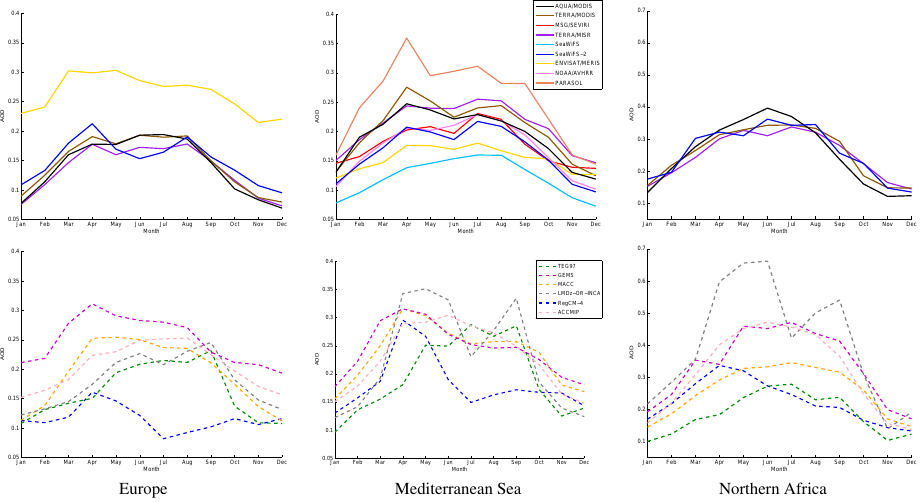
Fig. 4. AOD monthly averages at 550 nm for each dataset (satellites and models) over the European continent (region 8+9+10), the Mediter- ranean Sea (region 5+6) and Northern Africa (region 1+2).